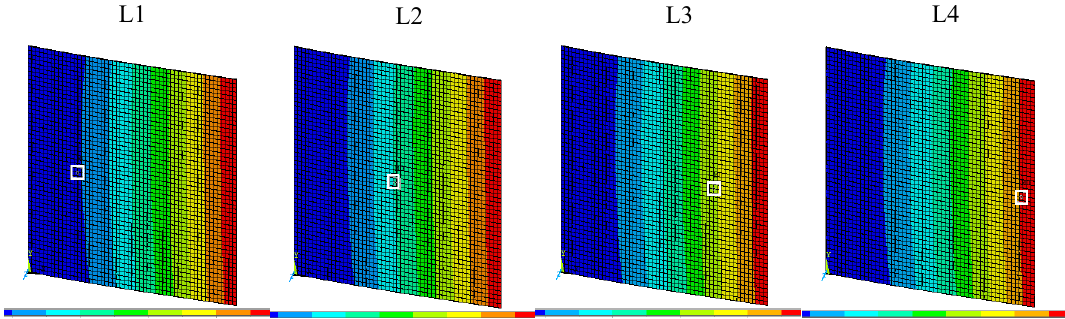
Figure 6. Fundamental numerical mode shapes of [±20] 2s plate with 30g (M/4) attached mass